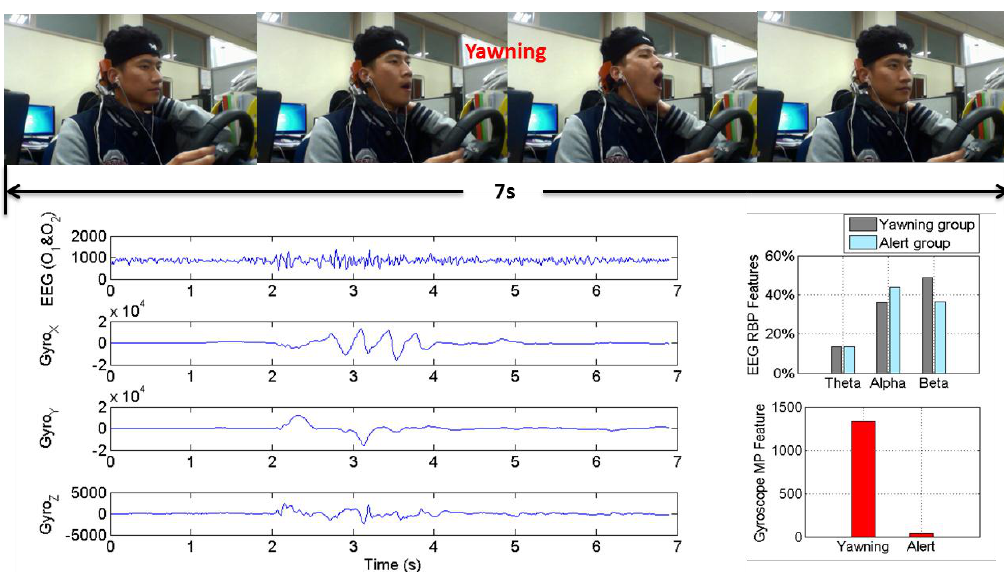
Figure 8. The typical slightly drowsy symptom, yawning, captured by video as well as EEG and gyroscope from a representative subject. The blue line charts represent EEG raw signals, X -axis, Y -axis and Z -axis signal of the gyroscope, respectively. The two bars on the right side of the line charts represent the EEG RBP features (the top) and the gyroscope MP features (the